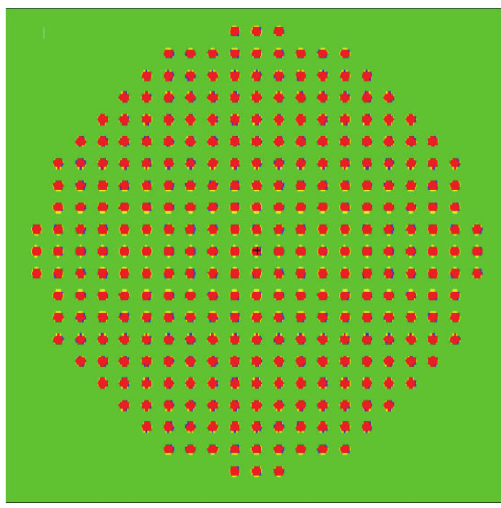
Figure 6: MCNPmodeling x-y view of theJSAreactor at mid-plane, showing fuel rods (red) arrangement surrounded by water (green) moderator/reflector.